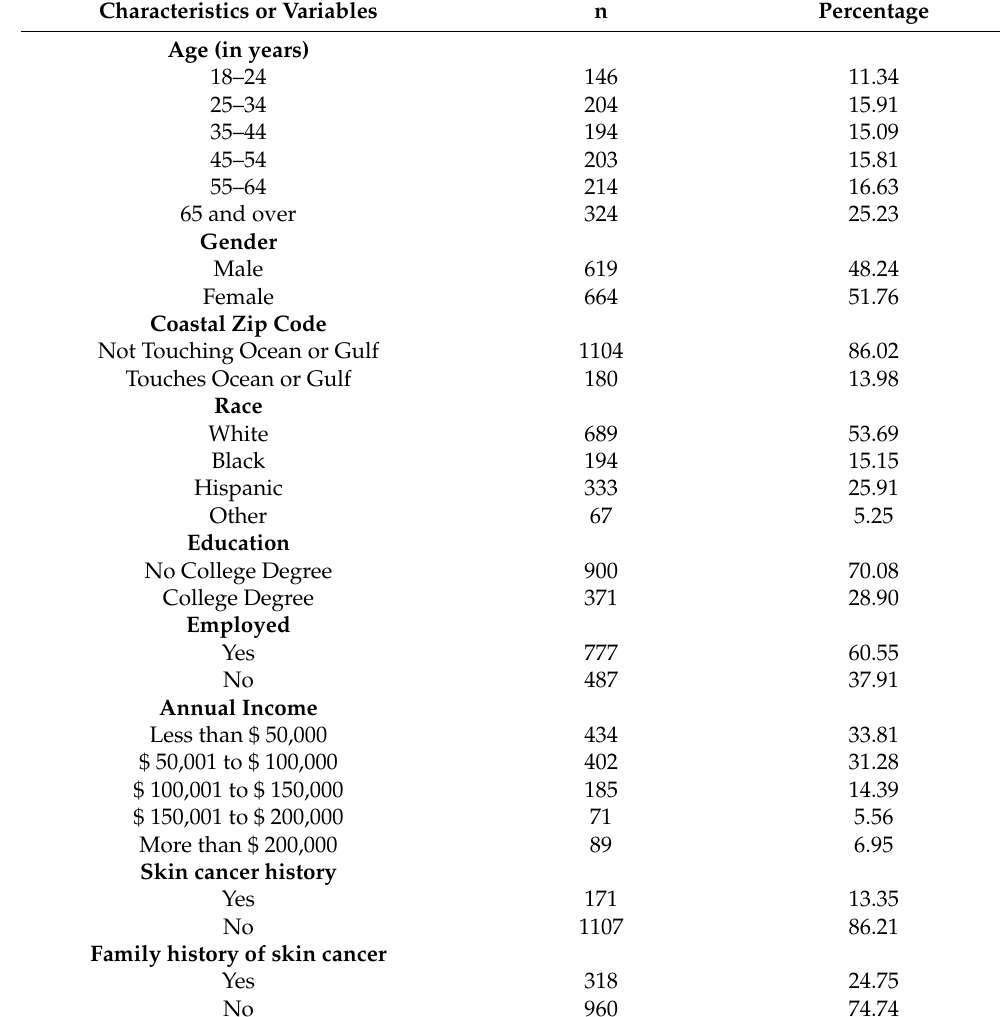
Table 1. Demographic characteristics of the sample population of Floridians ( N =